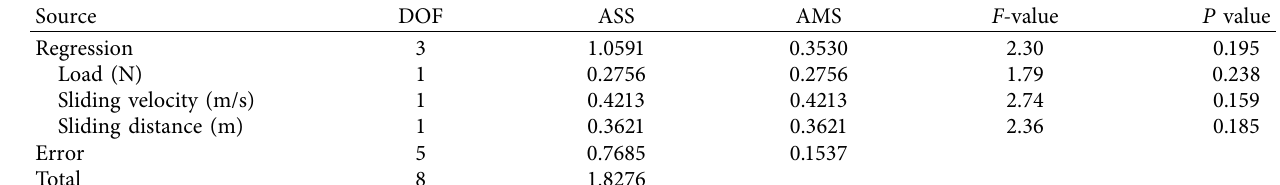
Table 6: ANOVA test for CoF.